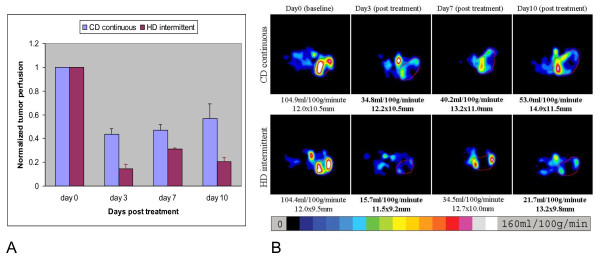
Effect of dosing and schedule of sorafenib on tumor perfusion. Figure 3A shows normalized serial tumor perfusion from 3 mice at 4 time points. Conventional dose of sorafenib lowers tumor perfusion by 57% by day 3. This decrease begins to resume by day 10 of therapy. In contrast, high dose intermittent sorafenib lowers perfusion by 85% at day 3. While tumor perfusion increases slightly at day 7 after there has been a 4 day lapse in treatment, by day 10, tumor perfusion is still low (20% of pretreatment). Tumor perfusion was significantly different in two arms at day 3 (P < 0.01) and day 10 (P < 0.001) as determined by two way ANOVA followed by Bonferroni posttest. Data are presented as mean normalized tumor perfusion with SEM. Figure 3B, shows a representative set of serial tumor perfusion images from mice treated with a conventional dose (upper row) or high dose intermittent (lower row) sorafenib. The blood flow values are shown in bold text are the values obtained while the mice were on sorafenib and the values that are not in bold are from mice before or off therapy. The tumor size was measured in long and short axes (mm) and the mean blood flow (mL/100 g/minute) are shown below each image. A color bar at the bottom represents the range of perfusion values from 0 to 160 mL/100 g/minute.